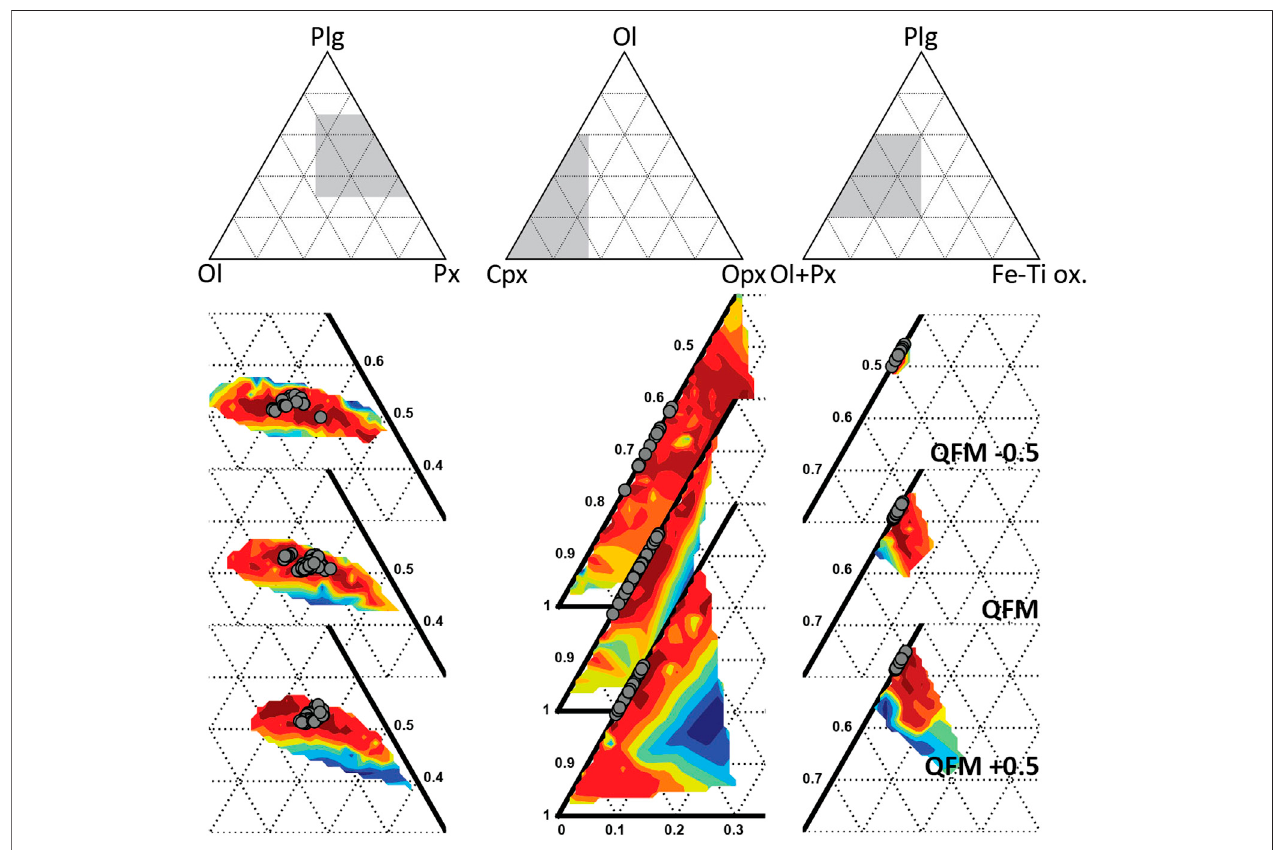
FIGURE 10 | Proportions of fractionated phases ofthe FC models at different f O conditions. Colored areas indicate the GoF value behavior of the FC models with 2 changes in the mineral proportions. Red colors indicate lower GoF values (good fi ts), whereas blue colors indicate high GoF values (bad fi ts). Grey circles indicate the mineralassemblageofthesolutionsofthePECcorrectionsbefore fi lteringbytheFeOtcontentoftheAKmeltfraction.Plg (cid:2) plagioclase,Ol (cid:2) olivine,Px (cid:2) clinopyroxene+ orthopyroxene, Cpx (cid:2) clinopyroxene, Opx (cid:2) orthopyroxene, Sp (cid:2)